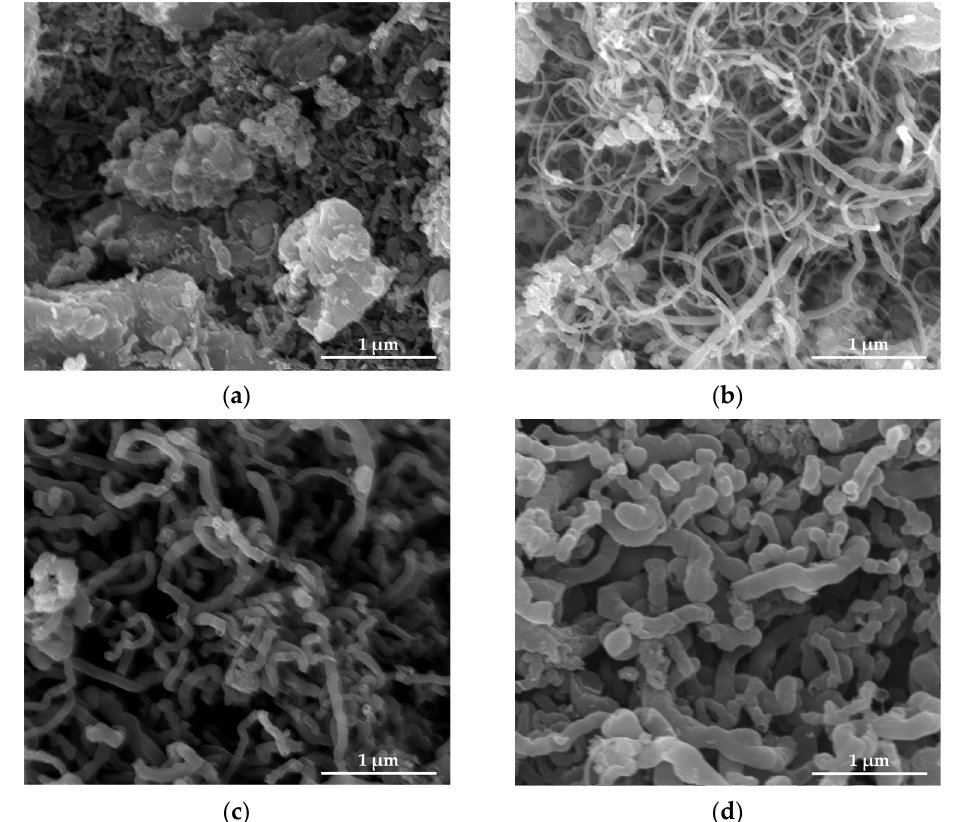
Figure 7. SEM images of CNTs synthesized at 500 ( a ); 600 ( b ); 700 ( c ); 800 °C ( d ).